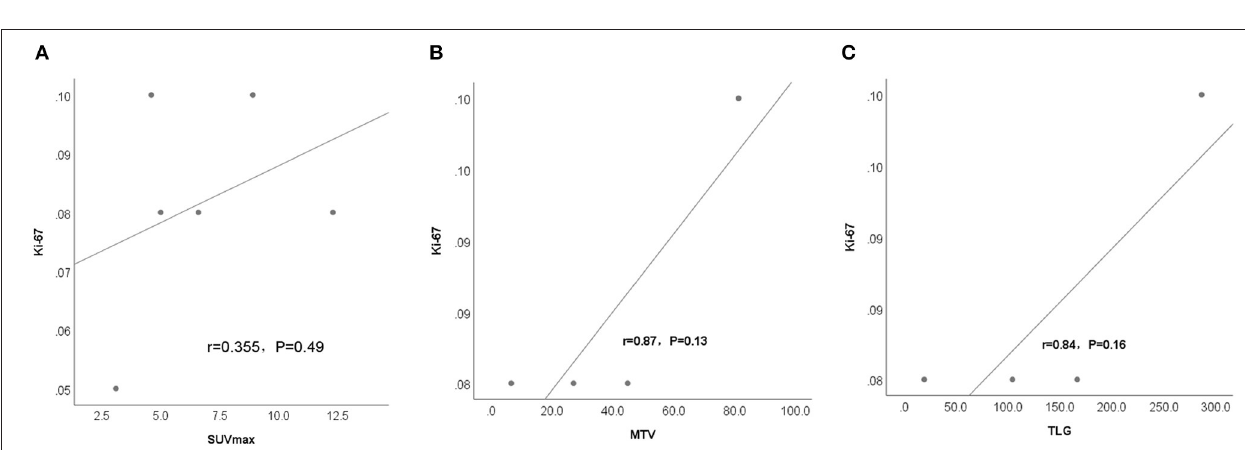
FIGURE 3 | Linear regression analysis shows no significant correlation between metabolism parametrix, including (A) SUV max , (B) MTV, and (C) TLG in the thymic lesions of the 6 patients with thymic MALT lymphoma and proliferation index